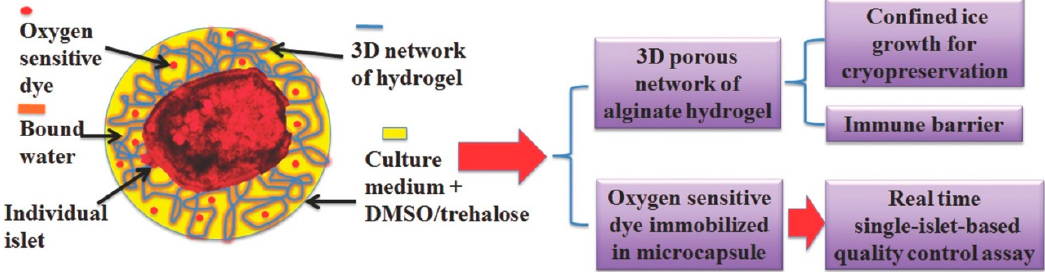
Figure 3. Quality control assay of cryopreserved pancreatic islets in microcapsules [39].